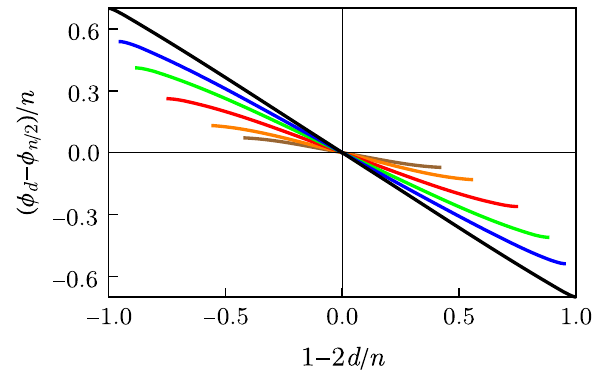
≡ ϕ ð E; d Þ of the oscillations FIG. 5. Plots of the WKB phase ϕ d of the coupling coefficient c ð E; d Þ with the Hamming distance d for a number of qubits n ¼ 1000 . Both axes are rescaled by n . The phase is plotted relative to its value at d ¼ n= 2 . We set the energy E ¼ E ð 0 Þ , where E ð 0 Þ ≃ − n − B 2 ⊥ reflects the overall shift of the impurity band due to the transverse field [cf. Eqs. (36) and (37)]. Different color curves correspond to different values of B ⊥ > FIG. 4. The blue curve shows the d dependence of the (rescaled) j E j =n with B ⊥ ¼ 1 . 1 (brown), B ⊥ ¼ 1 . 2 (orange), B ⊥ ¼ 1 . 5 coupling coefficients c ð E; d Þ computed from the exact expression (red), B ⊥ ¼ 2 . 1 (green), B ⊥ ¼ 3 . 2 (blue), and B ⊥ ¼ 10 (black). (23) with n ¼ 224 and E ¼ − 226 . 15 . We denote the binomial Each curve varies in its own range n= 2 − d ∈ ½ − m 0 ; m 0 (cid:2) , where coefficient as ð n . The transverse field is B ⊥ ¼ 1 . 459 . For Þ ≡ C n d d m 0 is given in Eq. (32) and determines the region of oscillatory this value of B ⊥ , the impurity band levels E ð z lie approximately j Þ behavior of the coupling coefficients (see Appendix B for in the middle of the interval between the p ¼ 34 th and p ¼ 35 th excited energy levels − B ⊥ ð n − 2 p Þ of the driver Hamiltonian. Red points depict the d dependence of the same rescaled coefficients c ð E; d Þ given by G exp ð n θ Þ and determined by the n= 2 − d;n= 2 asymptotic WKB expressions given in Appendix B [see Eqs. (B10) and (B13)]. Dashed lines indicate the boundaries of the oscillatory behavior of the WKB solution [Eq. (B9)]. The inset shows the plot for the exponential d dependence of the rescaled coupling coefficient − c ð E; d Þ in the region of its monotonic behavior d ∈ ½ 1 ; n= 2 − m 0 ð E Þ(cid:2) [cf. Eqs. (B13) and (29)]. The solid blue line corresponds to the exact expression (23), while the approximate WKB solution is shown with red points.